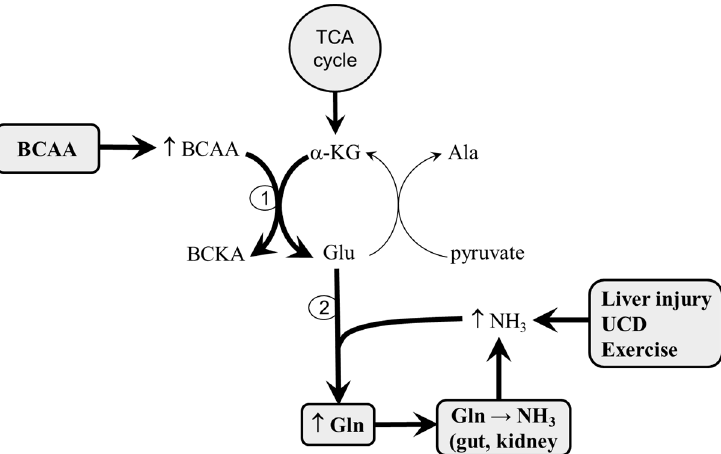
Figure 1. Supposed effects of branched-chain amino acid (BCAA) administration in hyperammonemic conditions. In hyperammonemic conditions, most of the exogenous BCAAs are used for the synthesis of glutamate, which is a direct substrate for ammonia detoxification to glutamine (GLN). The results are the diversion of α -ketoglutarate ( α -KG) from the TCA cycle (cataplerosis) and GLN catabolism to ammonia in the visceral tissues (particularly the gut and kidneys). When the detoxification of ammonia to urea is compromised, a vicious cycle, in which enhanced ammonia concentrations activate GLN synthesis, is activated [25].